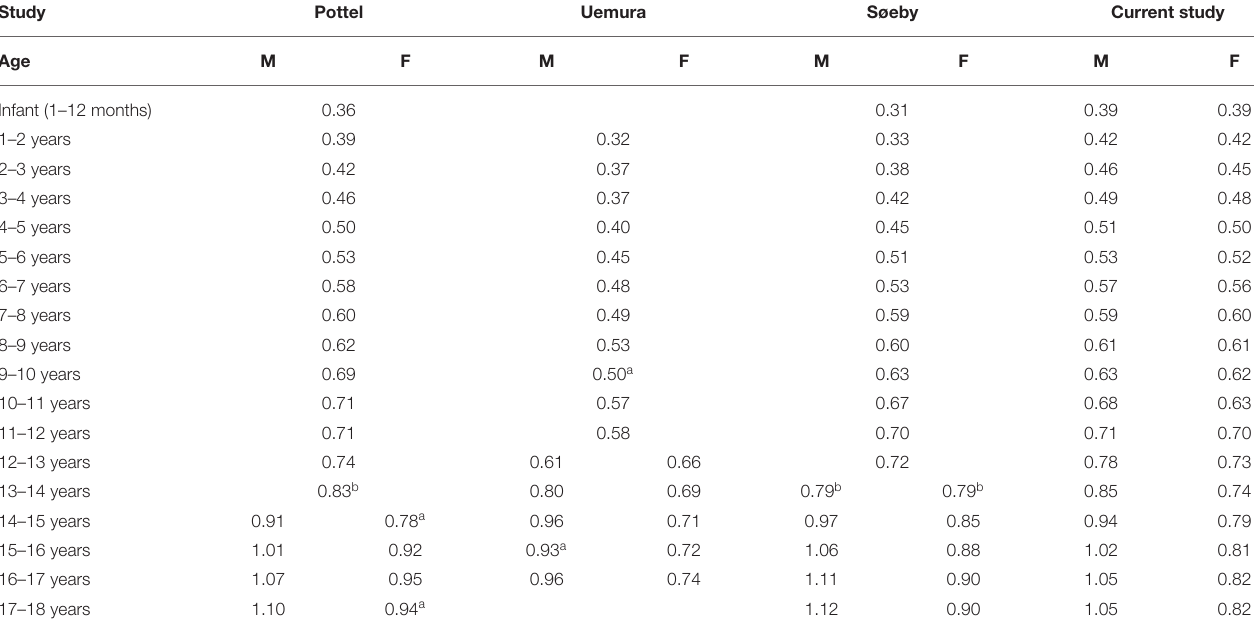
TABLE 2 | Upper reference limits (P97.5) of serum creatinine (mg/dL) in different studies. Study